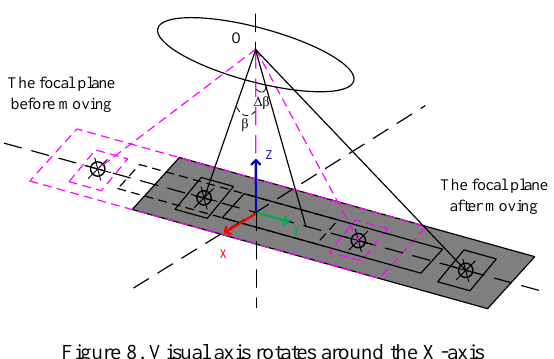
Figure 8. Visual axis rotates around the X-axis